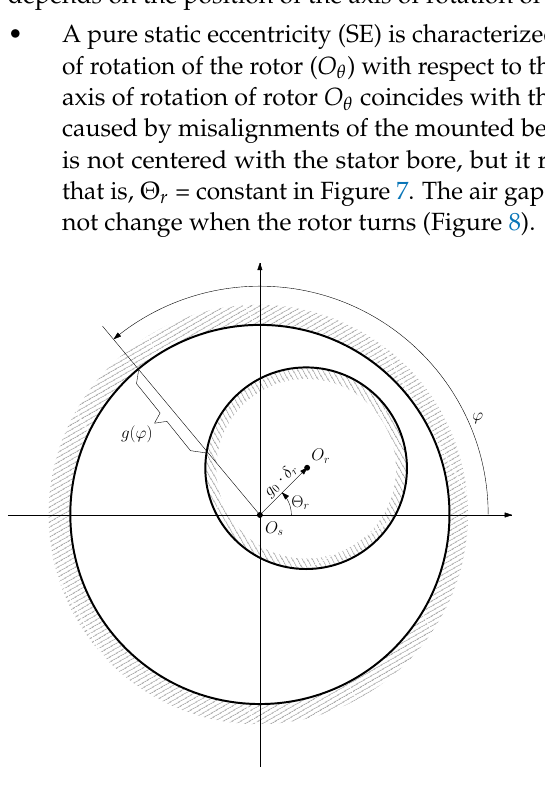
Figure 7. Air gap length g ( ϕ ) of an eccentric machine as a function of the angular coordinate ϕ , which depends on the position of the rotor centre O r with respect to the stator centre O s .